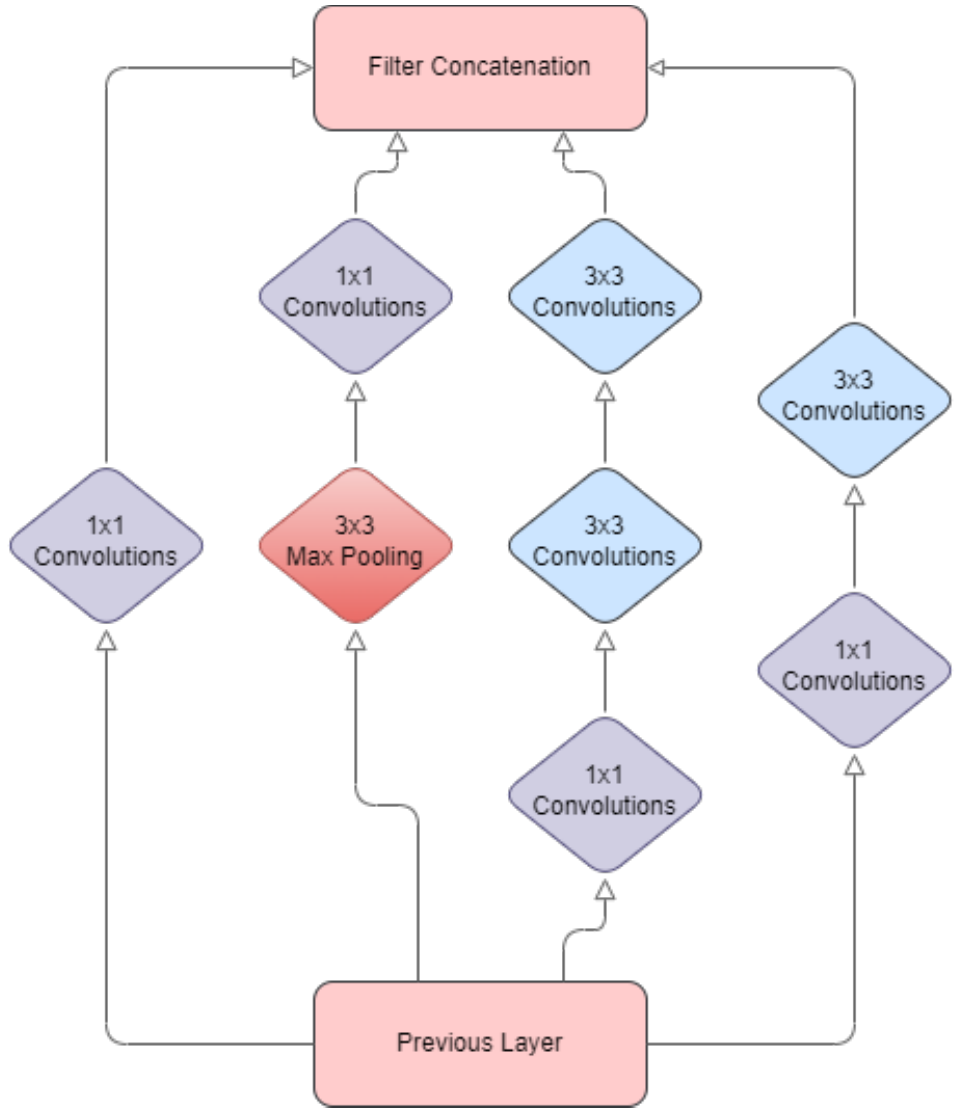
Figure 3. Inception module